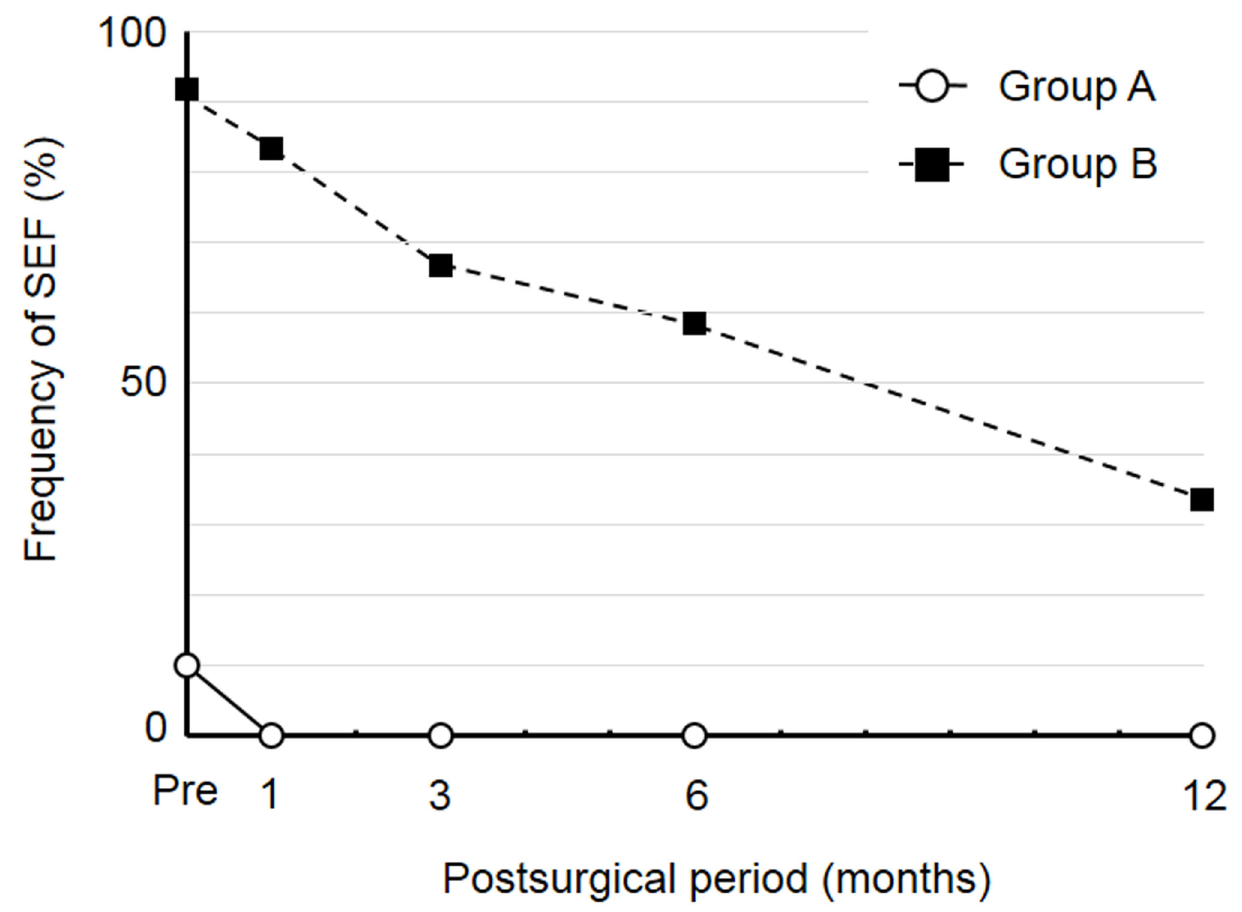
Figure 3. Frequency of SEF in groups A and B before and after